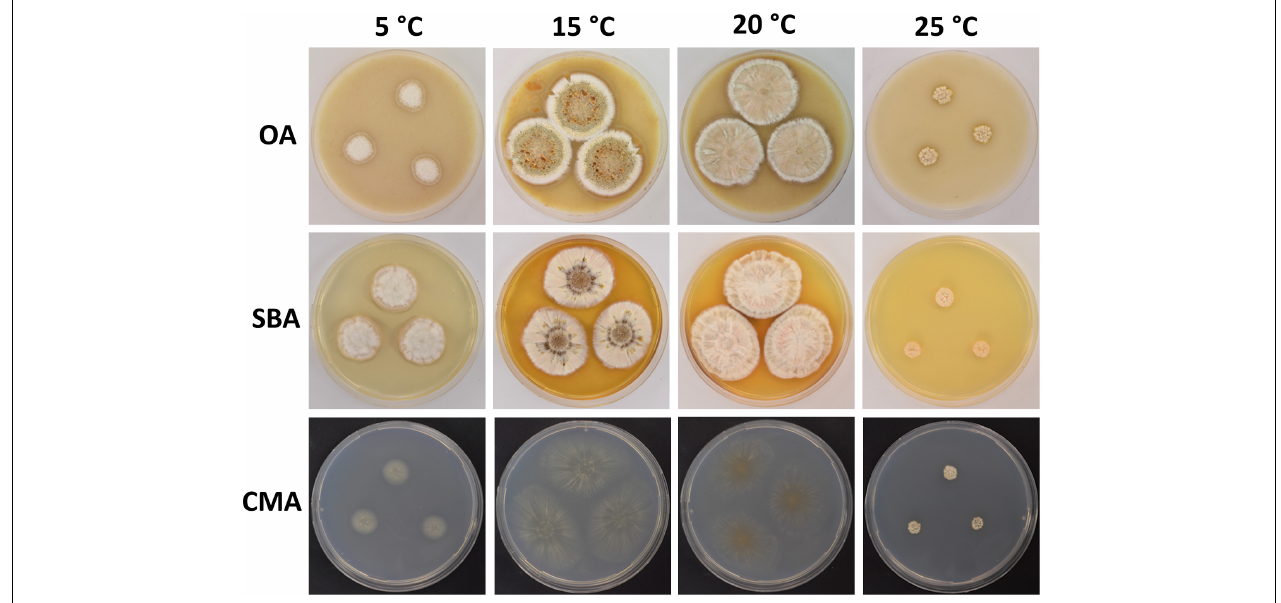
FIGURE 4 | Colony morphology of Pseudogymnoascus australis sp. nov. grown on OA, SBA, and CMA media at 5, 15, 20, and 25 ◦ C after 28 days of incubation.